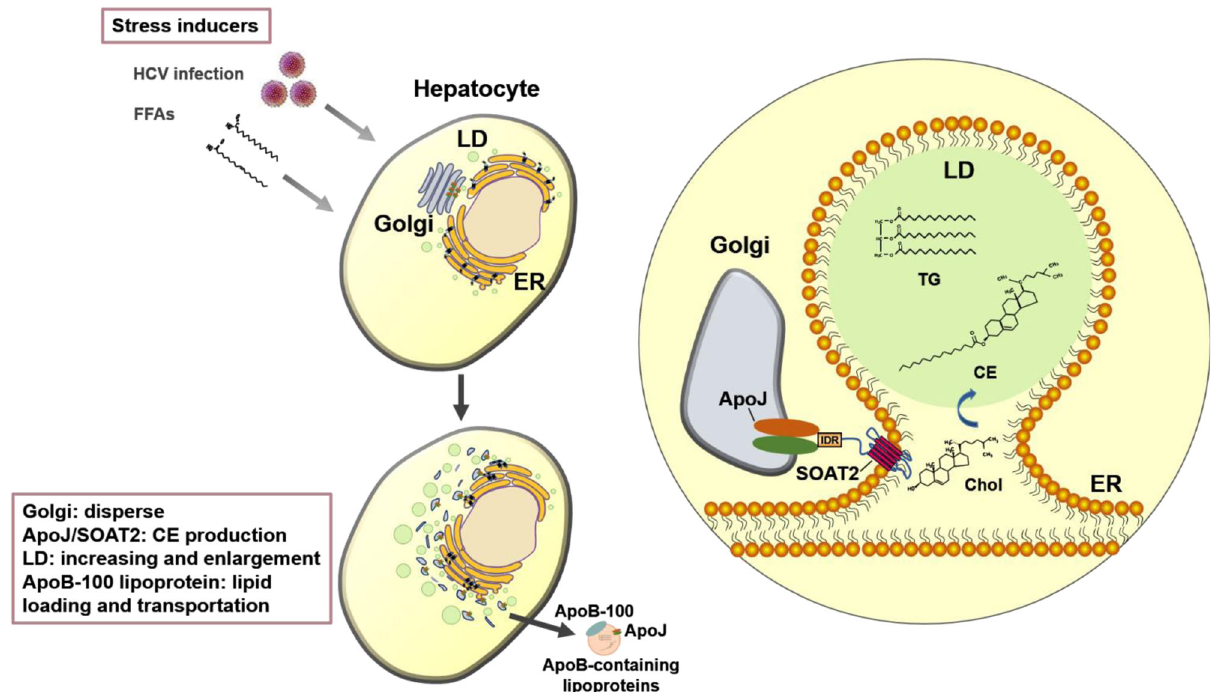
Fig. 7 The proposed model of ApoJ/SOAT2 axis in stress-induced hepatosteatosis. In hepatocytes facing stress, ApoJ mobilizes along with dispersed Golgi to the Golgi – ER contact site, where ApoJ interacts with ER-resident SOAT2 at the N-terminal IDR region and coordinates Chol esteri fi cation to produce CE for LD deposition and lipoprotein loading.